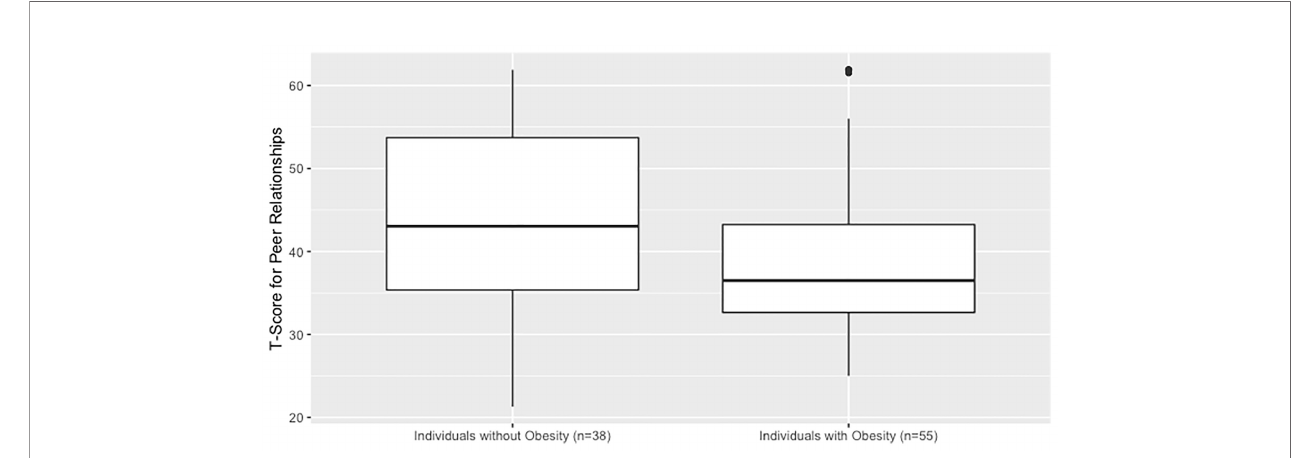
FIGURE 1 | Social function in children and adolescents with craniopharyngioma without vs. with hypothalamic obesity. PROMIS parent-proxy measure of pediatric peer relationships. Caregivers completed a validated questionnaire which generates a quantitative T-score of their child ’ s social function. The questionnaire is designed to have a reference population mean of 50 and SD of 10, and a higher value corresponds to better social function.